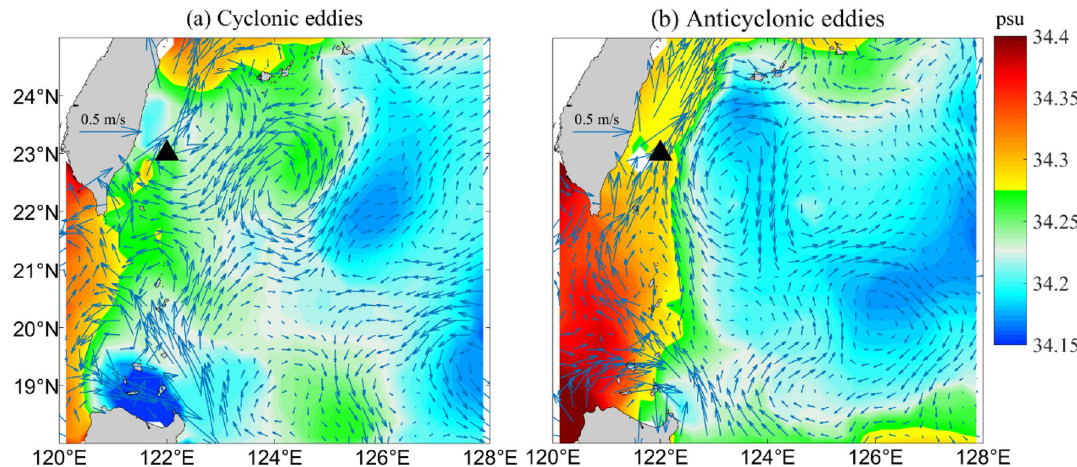
Figure 9. Relationship between the circulation and water mass off the eastern Taiwan. ( a ) Composite map of salinity (colors) and current (black arrows) averaged between 26.4 and 26.8 σ θ east of Taiwan for cyclonic eddies and ( b ) a composite map of anticyclonic eddies. The black triangle is the mooring site. Figures were plotted using MATLAB R2016b (http:// www. mathw orks.